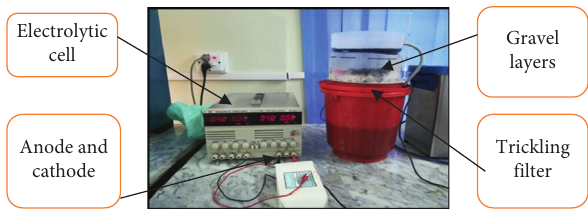
Figure 3: Trickling filter. It consists of gravels layer, electrolytic cell, and anode and